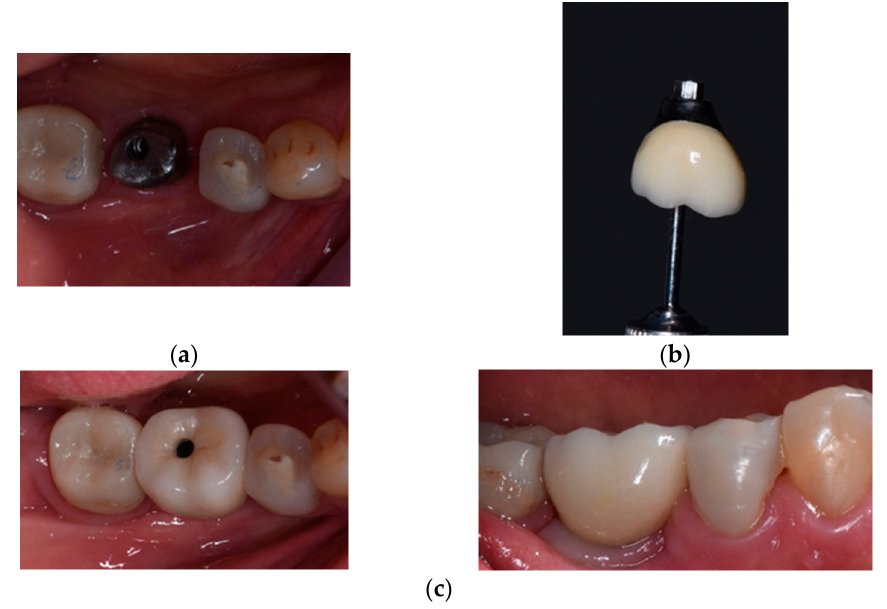
Figure 2. Prosthetic restoration used for Group B.